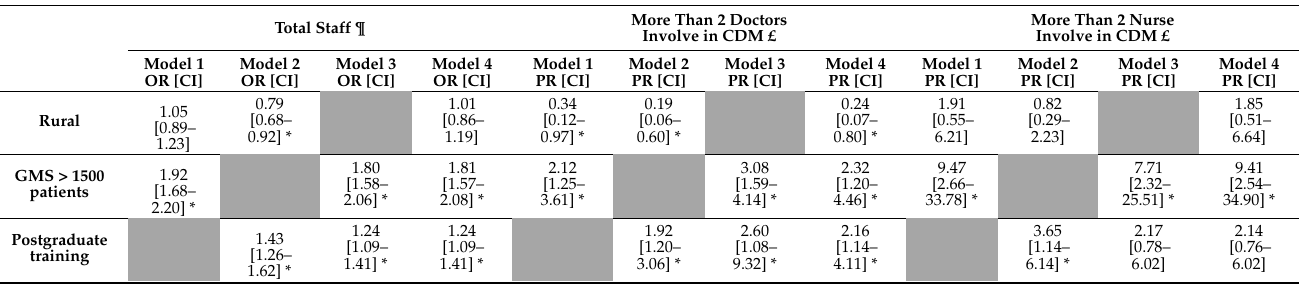
Table 3. Model showing association between staff involvement in CDM programme by practice location, size, and post-graduate